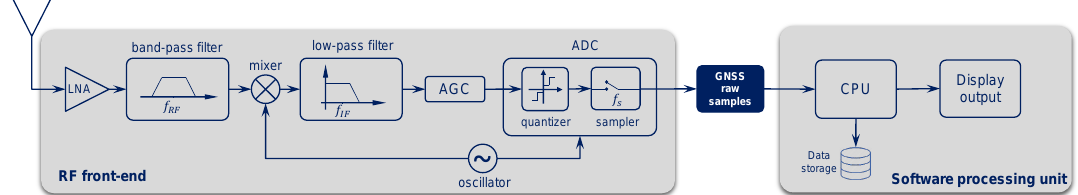
Figure 3. GNSS software-defined radio (SDR) data acquisition and processing system. ADC: analog-to-digital converter; AGC: automatic gain control; LNA: low noise amplifier; RF: radio